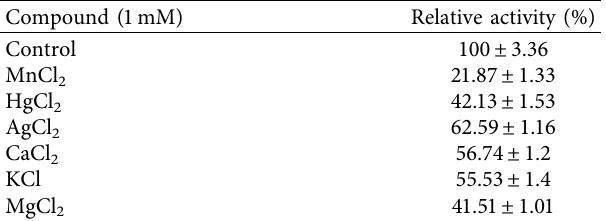
Table 3: Effect of metal ions on K . flava Y4 lipase activity.